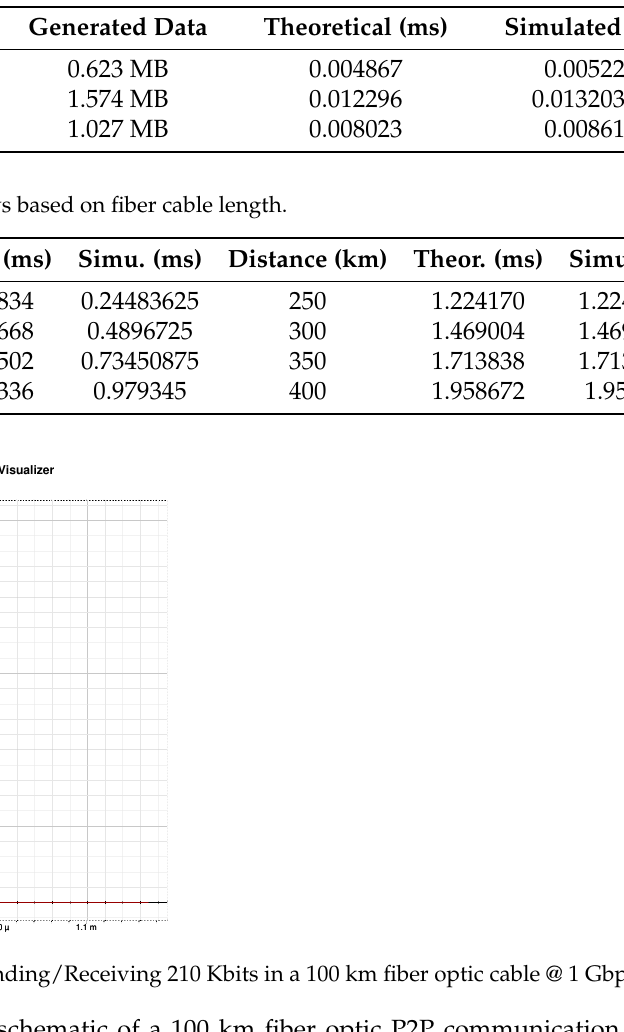
Table 9. Transmission delays per RTU type.